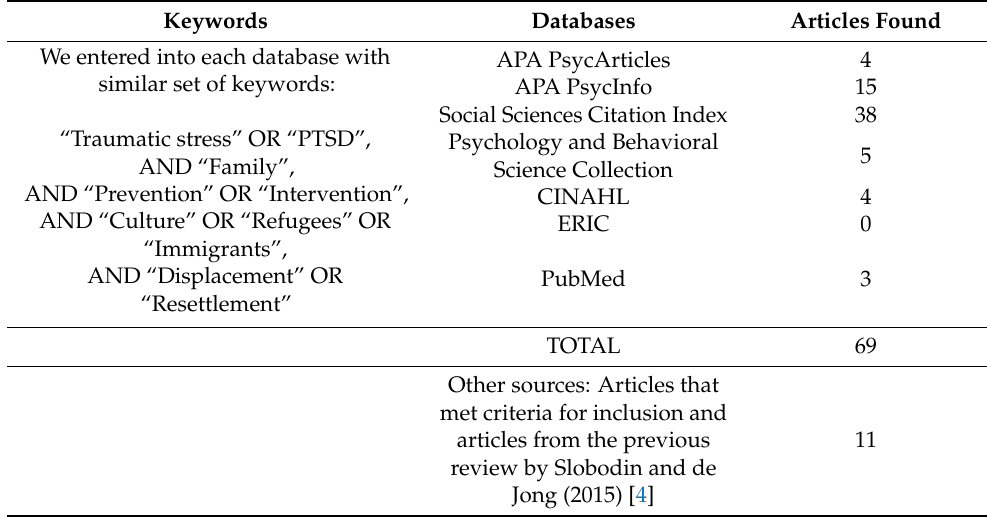
Table 1. Description of search